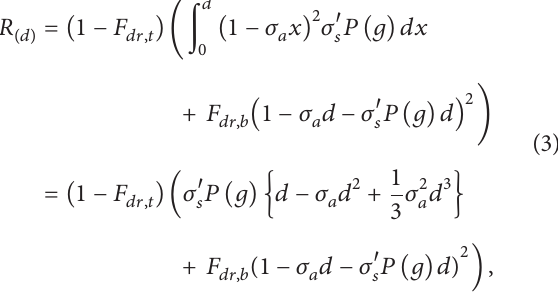
Figure 1: Control point sampling and wound warping process.